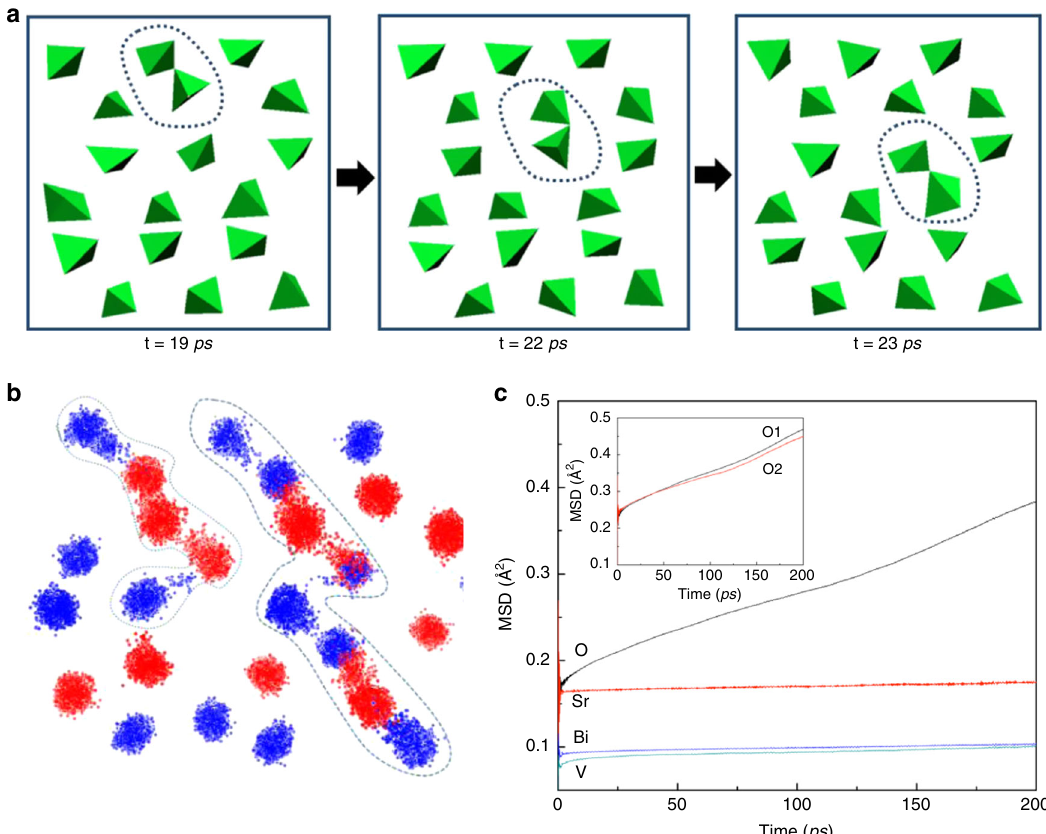
Fig. 6 Oxygen vacancy migration in Sr 0.0625 Bi 0.9375 VO 3.96875 . a Snapshots from MD simulation at 1400 °C showing long-range oxygen vacancy migration involving V 2 O 7 -dimer breaking and reforming. b Scatter plot of oxide ion positions roughly corresponding to the dimension in a from MD simulation. The V 2 O 7 -dimer breaking and reforming results in long-range diffusion paths (marked by dashed lines). Blue and red dots denote oxide ions originally at O1 and O2 sites, respectively. The Bi, Sr, V, and some O ions are omitted for clarity. c Calculated MSD values of Sr, Bi, V, and O atoms as function of time from the MD simulation at 1400 °C. The inset shows the MSD values for O atoms originally at sites O1 and O2, which are close to each other indicating that both oxygen sites participate equally in the oxide ion